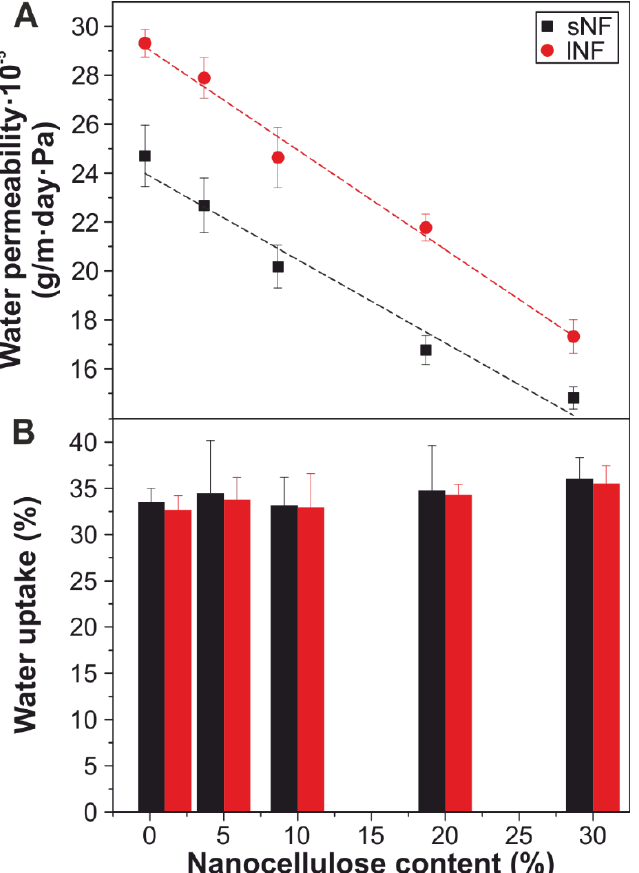
Figure 5. (A) Water permeability versus nanocellulose content. ( B) Water uptake values versus Figure 5. ( A ) Water permeability versus nanocellulose content. ( B ) Water uptake values versus nanocellulose content. nanocellulose